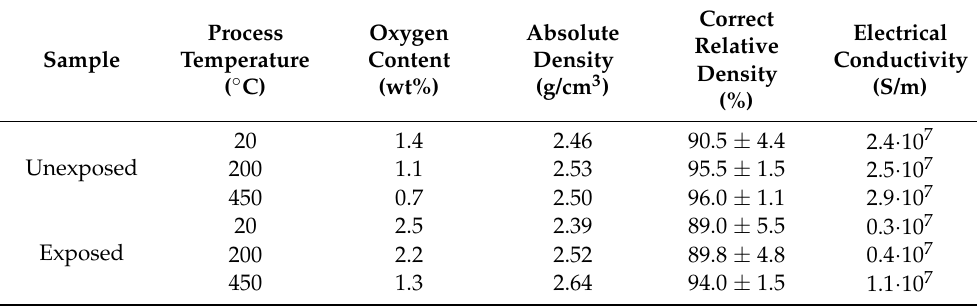
Figure 3. Correct relative density of unexposed and exposed Al compacts as a function of process temperature. Table 1. Density and electrical conductivity of unexposed and exposed Al